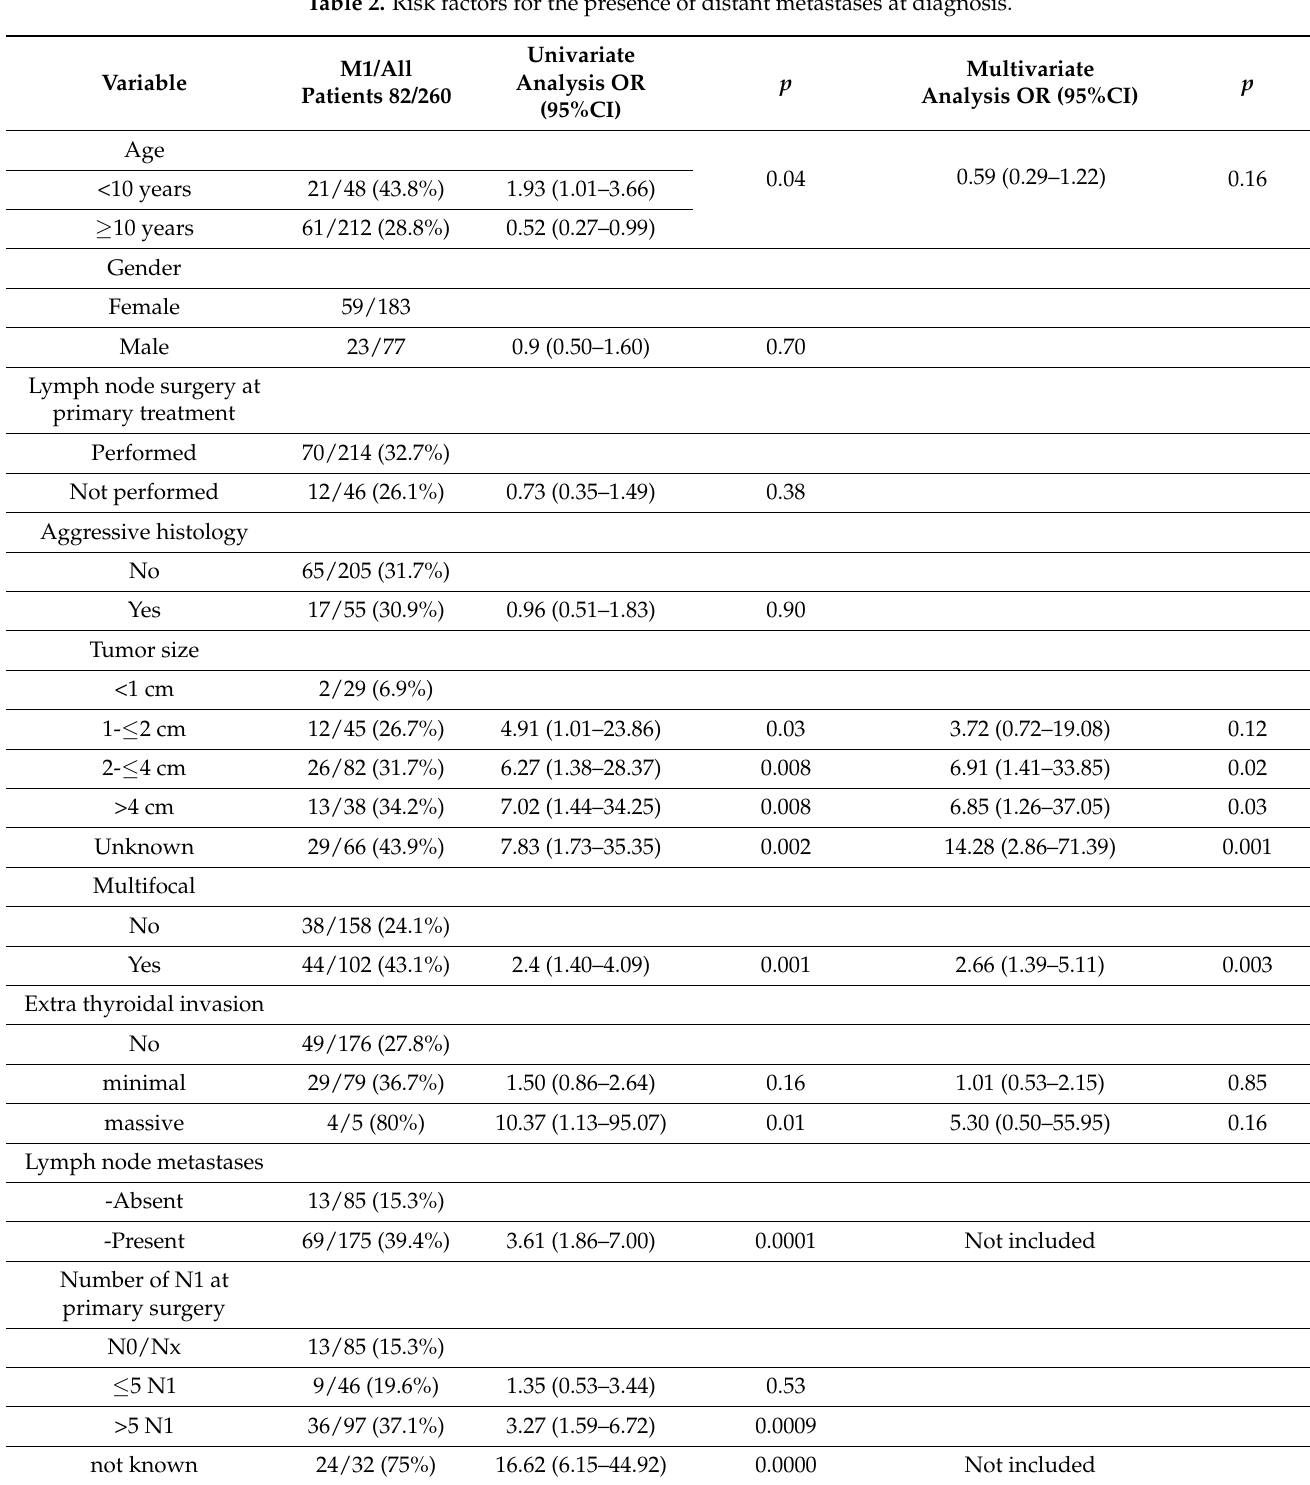
Table 2. Risk factors for the presence of distant metastases at